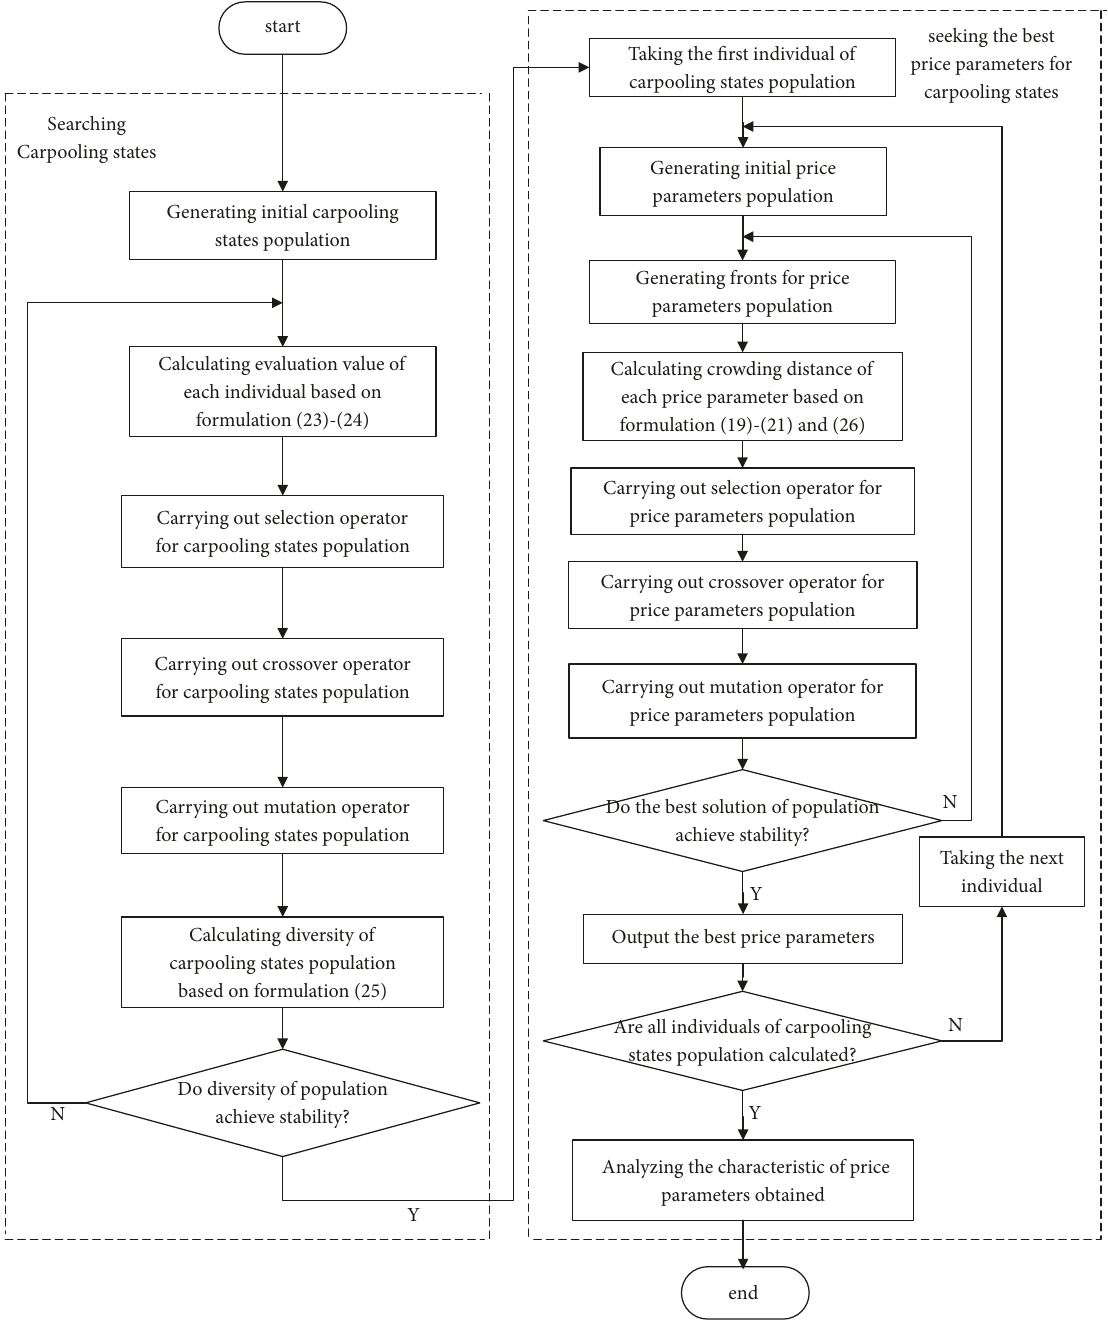
Figure 2: The algorithm